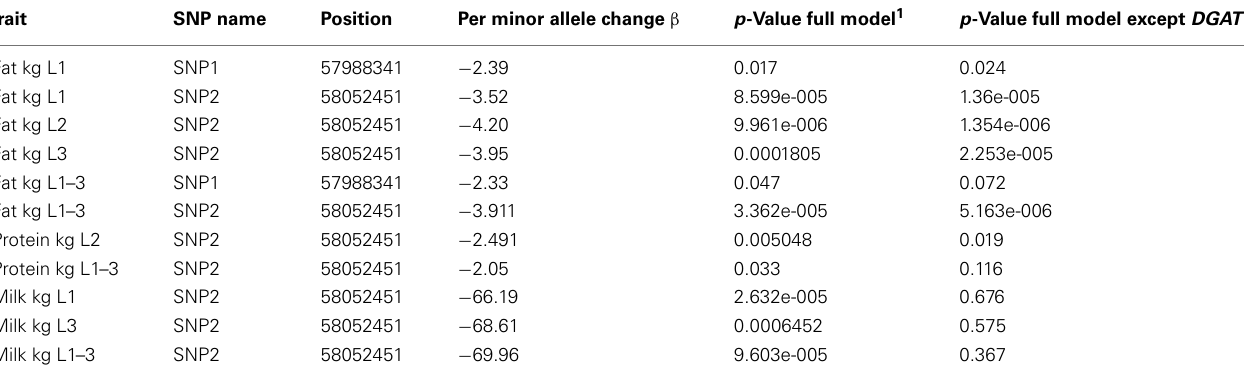
Table 2 | Significant associations between different milk traits and SNPs of the most significant haplotype block 4. Trait